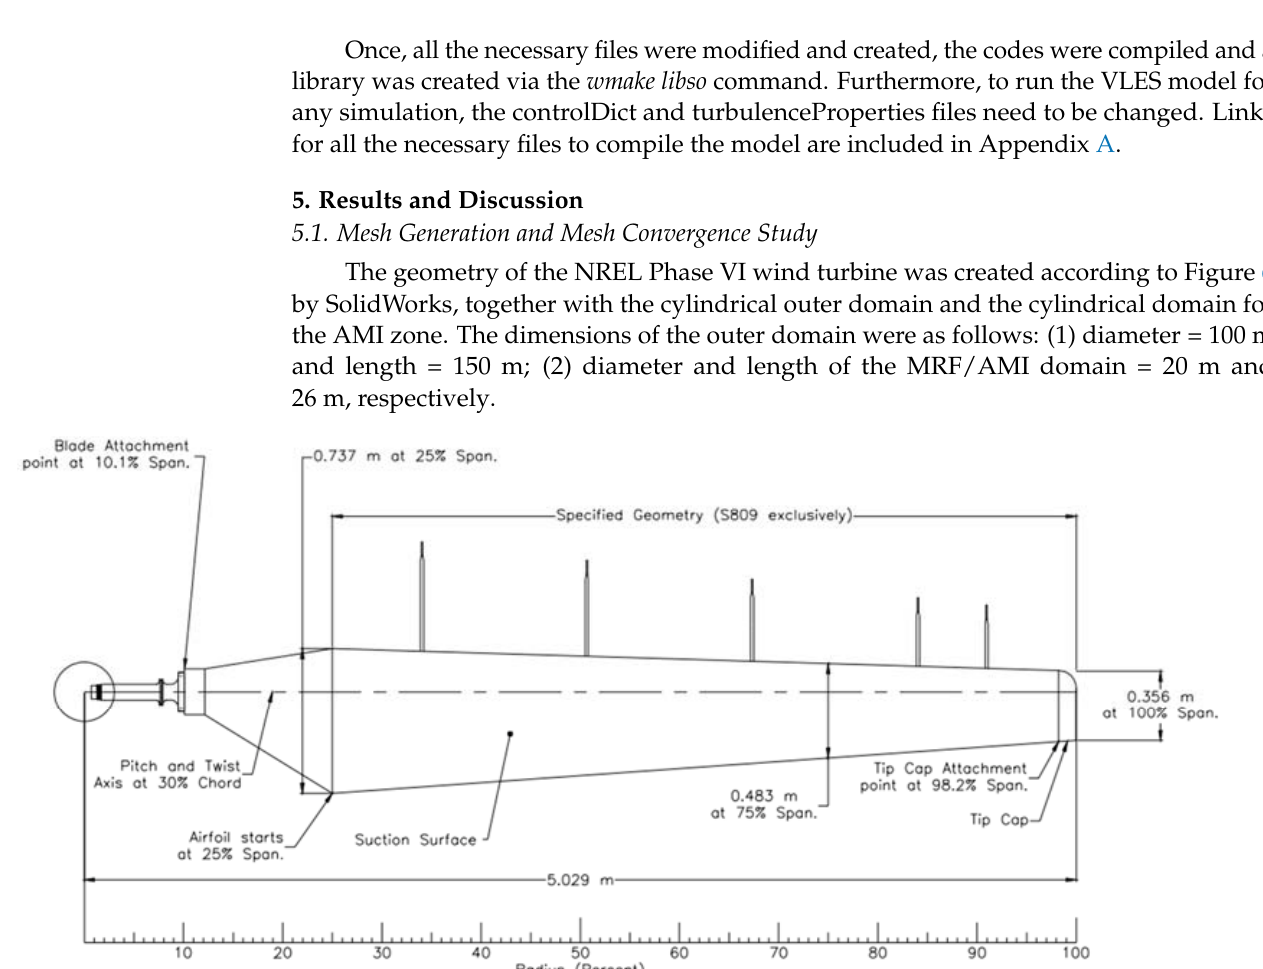
Figure 5. The recommended values and model constants.